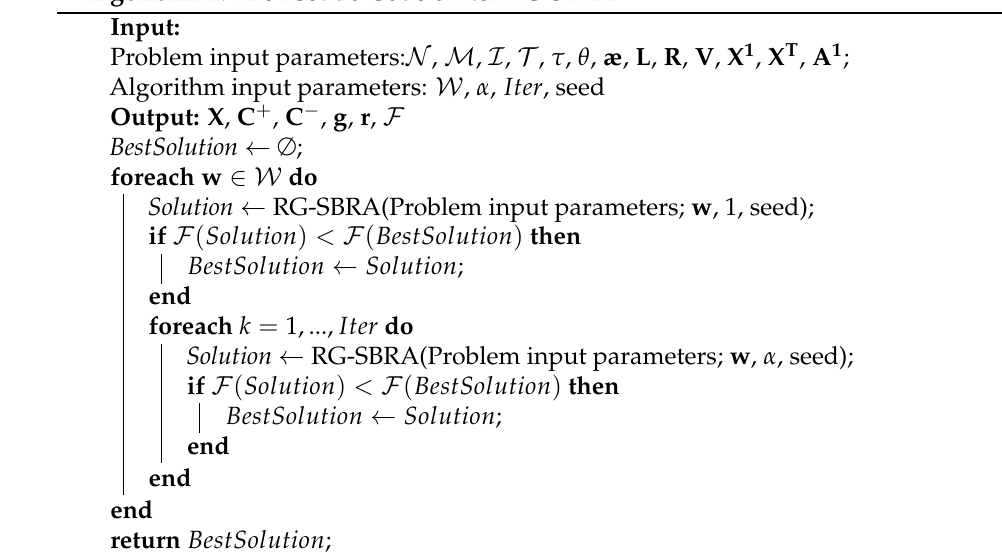
Algorithm 2: The Pseudo Code of